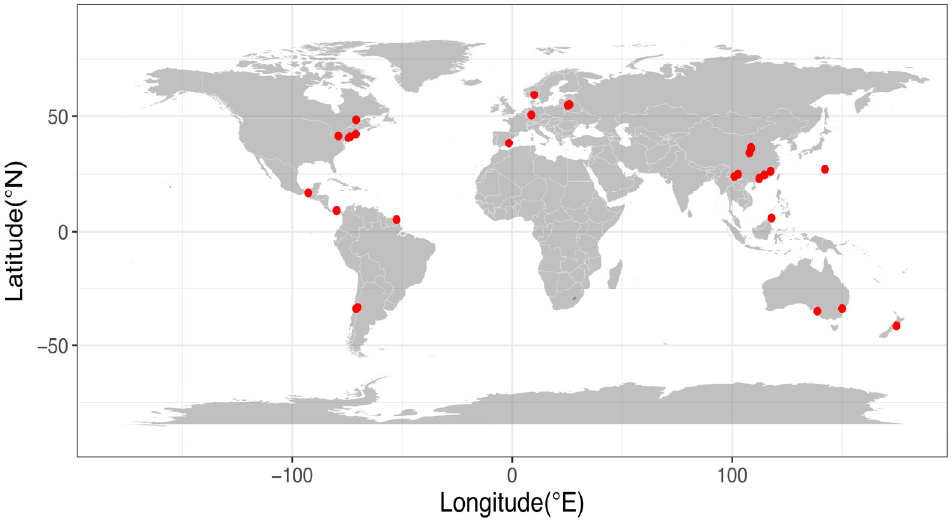
Figure 1. Locations of the collected